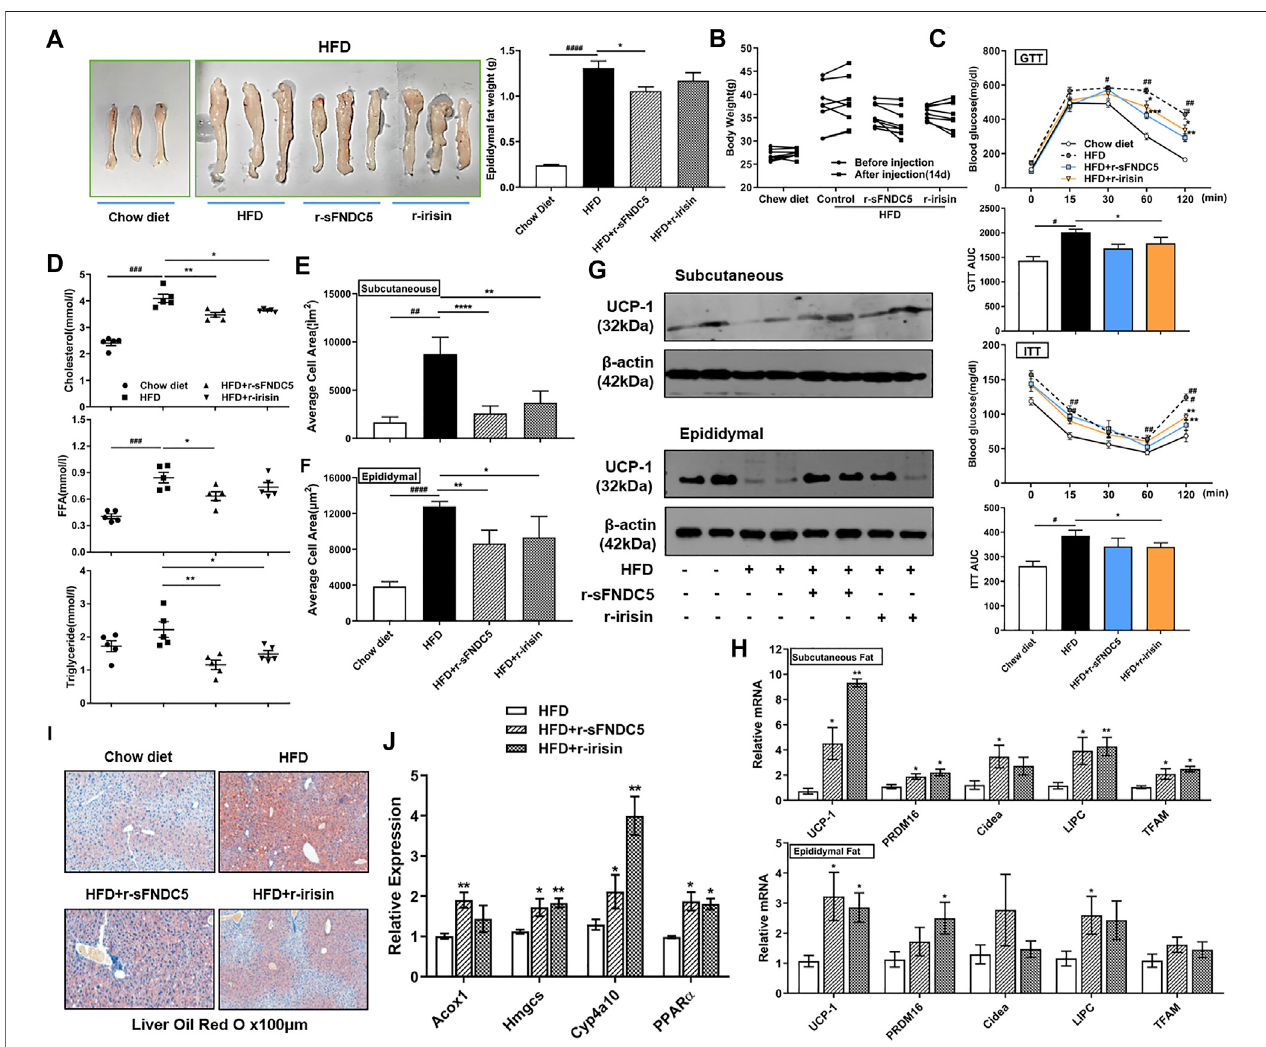
FIGURE 6 | r-sFNDC5 attenuated diet-induced obesity, glucose metabolism/insulin sensitivity, and dyslipidemia. HFD induced obese C57BL/6 mice were i.p. injected with r-sFNDC5, r-irisin (0.5 μ g/g/day), or saline daily for 14 days, and C57BL/6 mice fed with chow diet were injected with saline as a negative control ( n (cid:1) 4 – 9/ group). (A) Morphology (left)and weight(right) ofepididymalfat from different mice groups. (B) Bodyweights, (C) glucose tolerance test, (GTT) and insulin tolerancetest (ITT) of mice before and after injection of saline, r-sFNDC5, or r-irisin for 14 days. (D) Serum levels of cholesterol, triglyceride, and free fatty acid (FFA) levels in different mice groups. Mice were fasted overnight before the measurement. (E , F) Quanti fi cation of mean adipocyte size in subcutaneous and epididymal fat in different mice groups. (G) r-sFNDC5 and r-irisin upregulated the expression of UCP1 in subcutaneous and epididymal fat from different mice groups. β -Actin expression was used as a control in western blotting analysis. (H) Expression of selected biomarker genes of browning and lipolysis in subcutaneous and epididymal fat from different micegroups. (I) r-sFNDC5andr-irisinreducedthelipidaccumulationinliversectionsofobesemice,and (J) expressionoffattyacidoxidation-relatedgeneexpressionin livers from different mice groups. Values are mean ± SEM. # p < 0.05, ## p < 0.01 ### p < 0.001 and #### p < 0.0001 vs. chow diet mice; * p < 0.05, ** p < 0.01 and *** p < 0.001 vs. HFD mice.